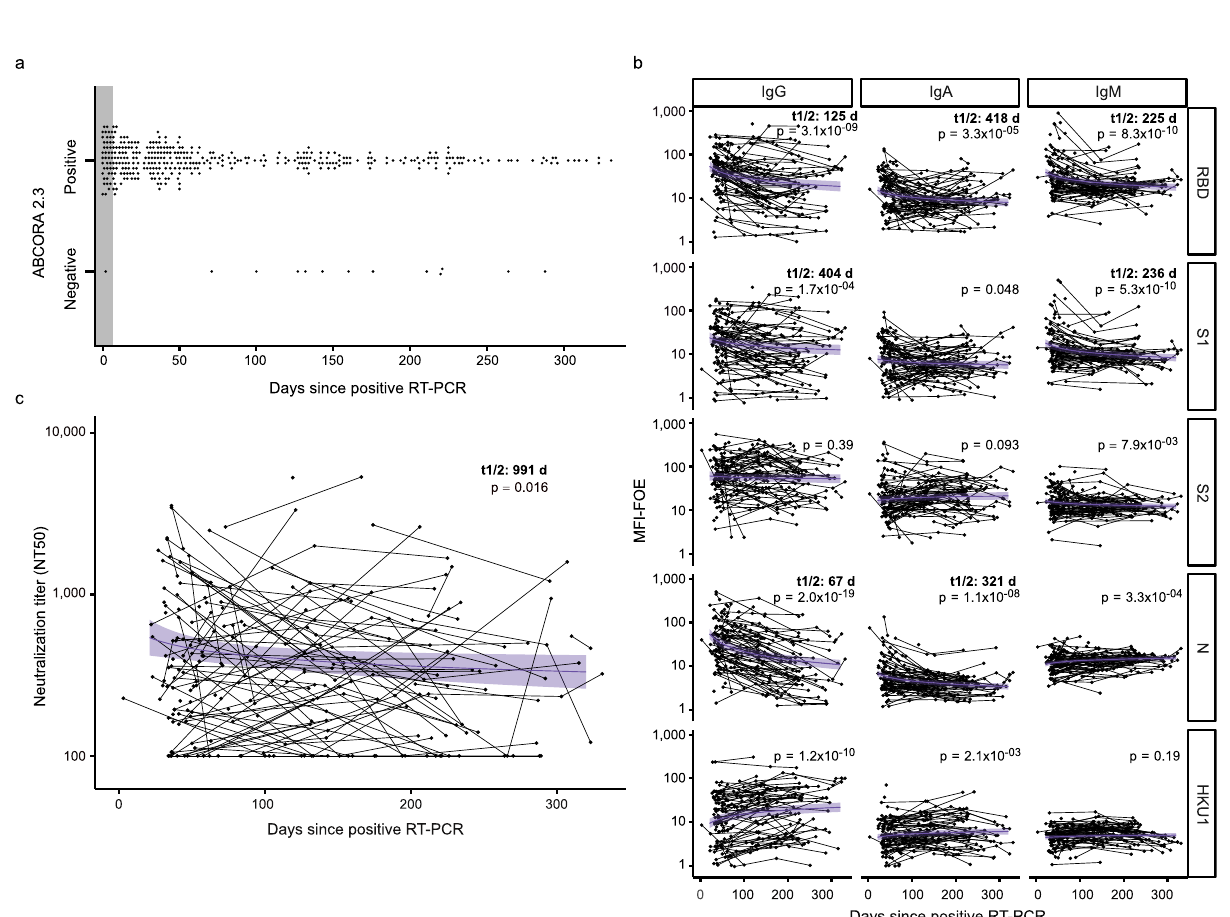
Fig. 4 Predicting neutralization capacity as a function of binding activity. a SARS-CoV-2 positive donors ( N = 467) were strati fi ed into high neutralizers (NT50 > 250, N = 332; blue) and no/low neutralizers (NT50 < 250, N = 135; gray), based on their neutralization activity against Wuhan-Hu-1. b , c Comparison of the prediction ability of six different classi fi cation models using 100 cross-validation sets (divided as 80% for training and 20% for validation). b Comparison of models by area under the curve (AUC). Each dot corresponds to one cross-validation set. c Bayesian information criterion (BIC) of the fi ve models based on logistic regression. The different models are: Univariable logistic regressions (ULR). ULR-RBD: mean of MFI-FOE RBD. ULR-S1: mean of MFI-FOE S1. Multivariable logistic regression (MLR). MLR-S1, RBD: mean of S1 reactivity and mean of RBD reactivity. MLR-PCA2 and MLR- PCA4: MLR of 2 and 4 fi rst axis of PCA analysis, respectively. PCA was based on all 12 SARS-CoV-2 antibody reactivities measured by ABCORA 2.0. Random forest (RF) including all antibody reactivities measured by ABCORA 2.0. Boxplots represent the following: median with the middle line, upper and lower quartiles with the box limits, 1.5x interquartile ranges with the whiskers and outliers with points. d ULR-S1 estimated ROC curve based on full data set ( N = 467). e Measured NT50 value versus probability of NT50 > 250 as predicted by ULR-S1 in fi ve randomly chosen validation sets (each symbol corresponds to a validation set). Purple colored symbols indicate a higher than 0.70 probability of the respective sample to be neutralizing at NT50 > 250 and are therefore denoted as high neutralizers. Gray indicates samples with predicted neutralization NT50 < 250, therefore classi fi ed as no/low neutralizers. f Neutralization prediction based on a modi fi ed ULR-S1 model utilizing the diagnostic readout SOC instead of MFI-FOE values as input. Measured NT50 value versus sum of S1 SOC values (IgG, IgA, IgM) are depicted. Dashed lines correspond to a NT50 = 250 horizontally and the sum S1 SOCs = 9.7 vertically. The sum S1 SOCs = 9.7 corresponds to the thresholds depicted for ULR-S1 in ( d , e ). The gray shaded area corresponds to true positives (individuals with NT50 > 250 predicted as high neutralizers).